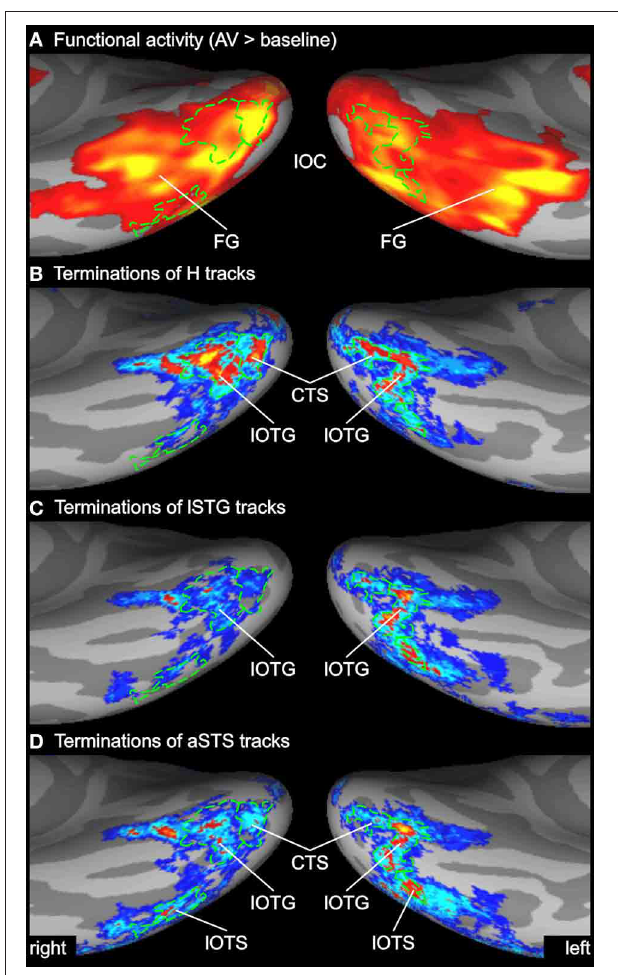
FIGURE 6 | Enlarged view of functional activity and track terminations in inferior occipito-temporal cortex. (A) Functional activity contrasting BOLD responses to all bimodal stimuli with BOLD responses to control stimuli (A0V0). (B–D) Termination maps for tracks seeded in the Heschl’s region (H), lateral superior temporal gyrus (lSTG), and anterior superior temporal sulcus (aSTS), respectively. Labels (ROIs) based on track terminations are shown in green. CTS, collateral transverse sulcus; lOTG and lOTS, lateral occipito-temporal gyrus and sulcus. See also Figures 2 and 3 for other